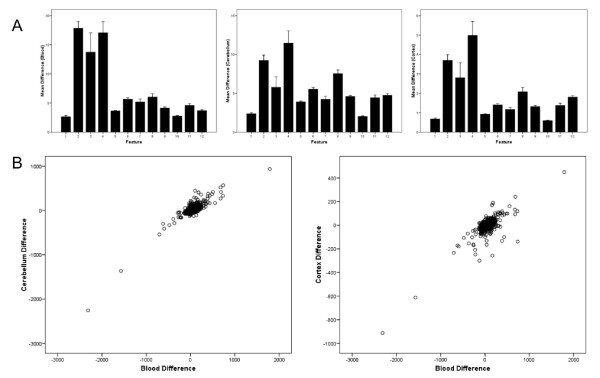
Between-individual variation in DNA methylation is often correlated between blood and brain. (a) Between-individual variation in DNA methylation is highest in blood and lowest in the cortex. All tissues show a similarly significant (ANOVA P < 0.001) distribution of variability across features, with the greatest between-individual variation occurring in non-promoter CGIs. Scores represent the mean difference in normalized MeDIP-seq read density between individual 1 and 2 for each of the feature categories. Error bars represent standard error of the mean. Features 1 to 4 = promoter, intragenic, 3', and intergenic CGIs; features 4 to 8 = promoter, intragenic, 3', and intergenic CGI shores; feature 9 = CDS; features 10 to 12 = HCPs, ICPs, and LCPs. (b) Between-individual differences in DNA methylation observed in blood are significantly (P < 0.001) correlated with differences observed in the cerebellum (correlation = 0.76) and cortex (correlation = 0.66) from the same individuals. Scores represent the mean difference in normalized MeDIP-seq read density between individual 1 and 2 for each of the quantified features.